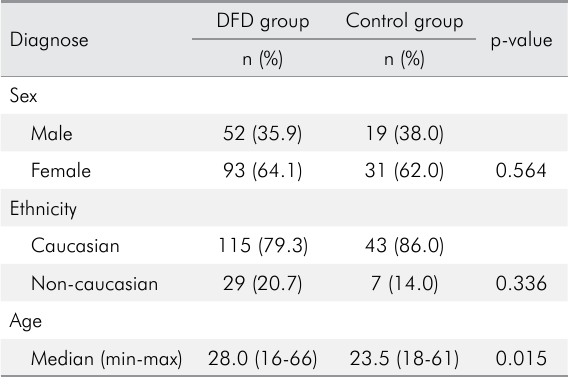
Table 1. Individual characteristics of individuals with dentofacial deformities (DFD) and control